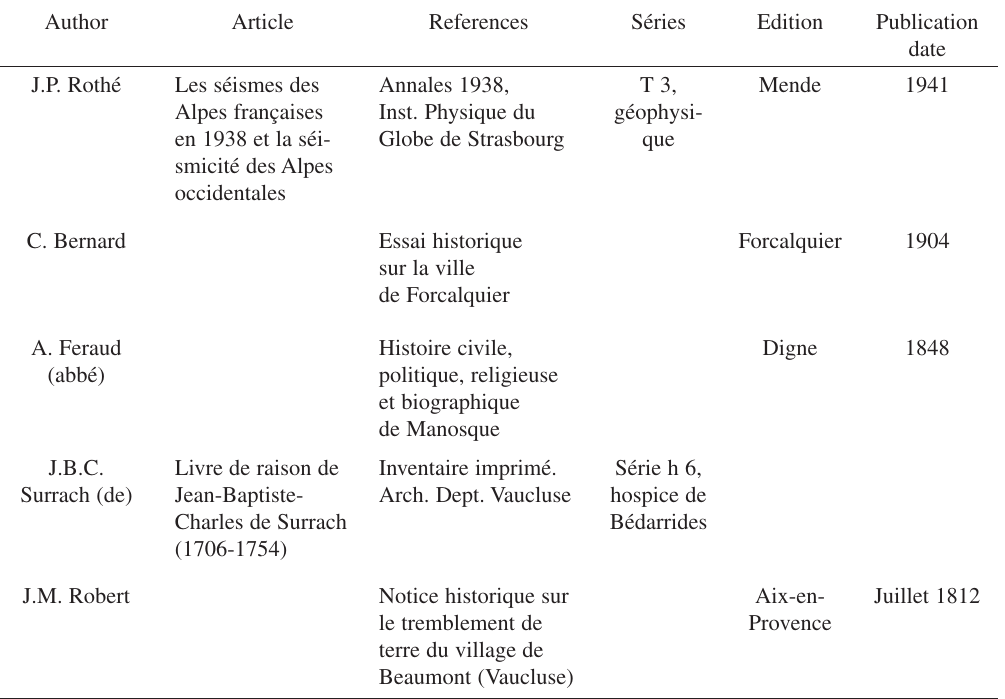
Table I. Example of the SISFRANCE referencing scheme for the 14 August 1708, Manosque earthquake (extrac- ted from www.sisfrance.net in